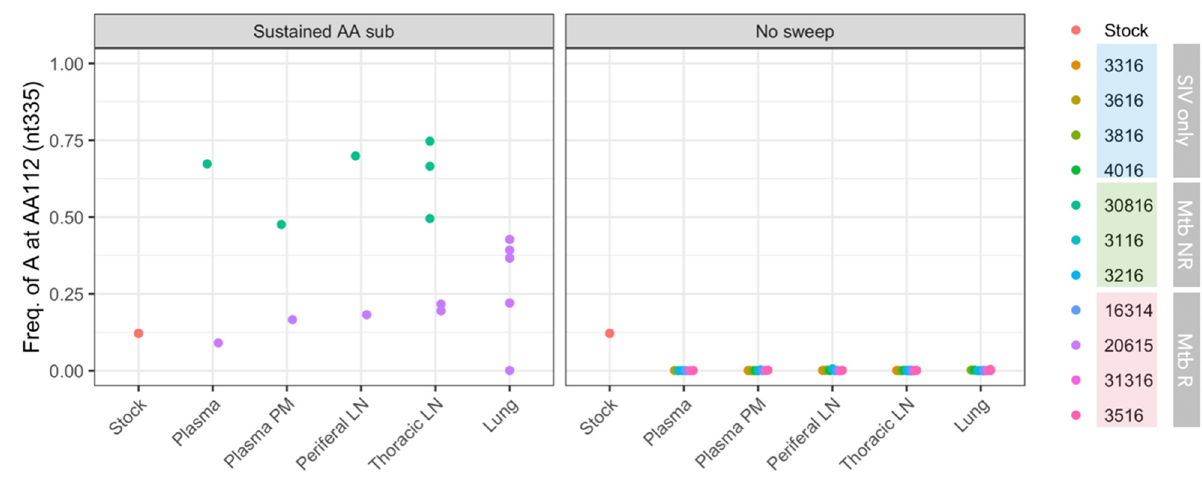
Figure 8. Frequencies of adenosine at nt335 (results in R112K substitution) in SIV isolated from different animals. Each dot represents a single sample. ‘Plasma’ represent plasma samples at an early time point, and ‘Plasma nex’ represents plasma samples at necropsy. Animal 30816 did not have lung samples.